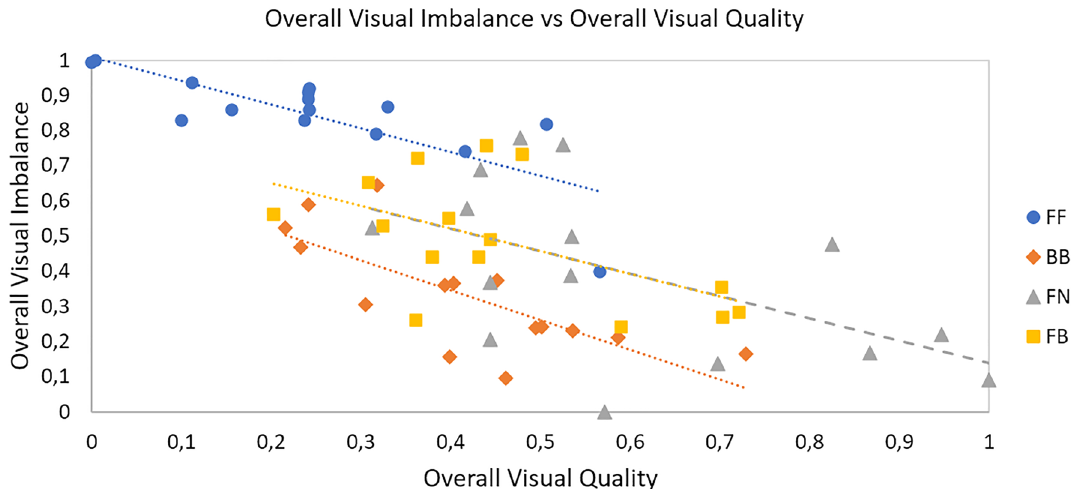
Figure 10. Overall visual imbalance (MAS-2EV polygon asymmetry) vs overall visual quality (MAS-2EV Area), for all tested corrections (far-far; bifocal-bifocal; far-near and